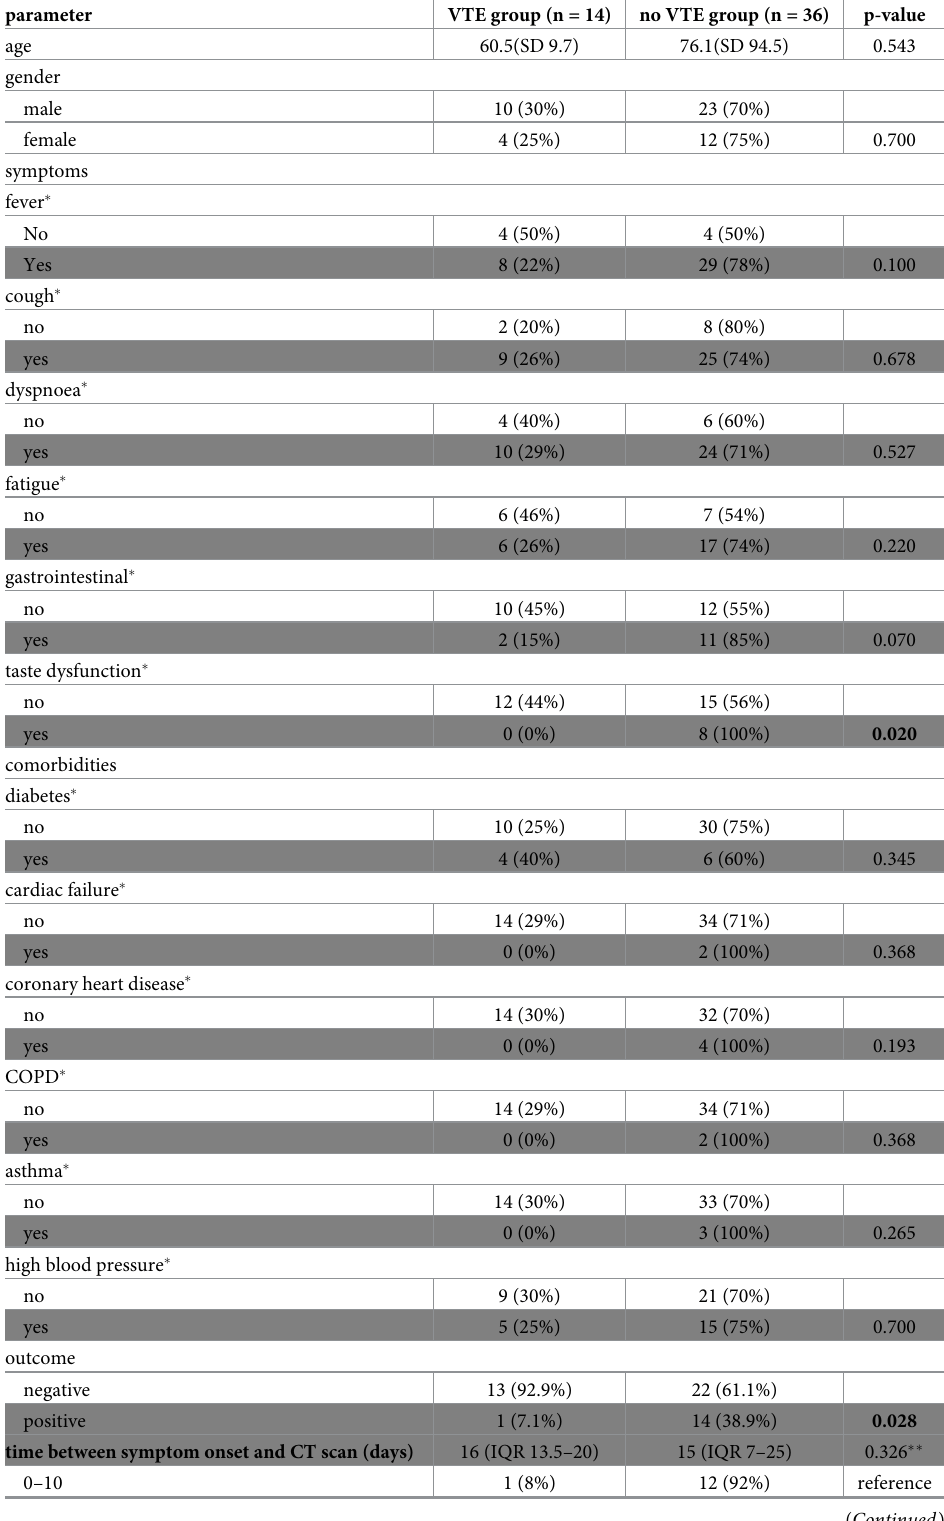
Table 4. Differences between VTE vs. no VTE in demographic data, clinical data, comorbidities and